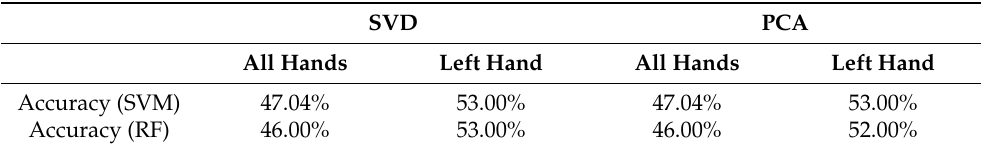
Table 3. The composite activity recognition using a set of optimal features derived from the subspace pooling technique. The feature are classified with k -fold (where k = 3) cross-validation. The average recognition accuracy with k -fold cross-validation is also presented.